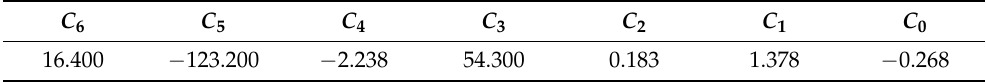
Table 2. Numerical values of coefficients C 0 – C 6 used in the split-window